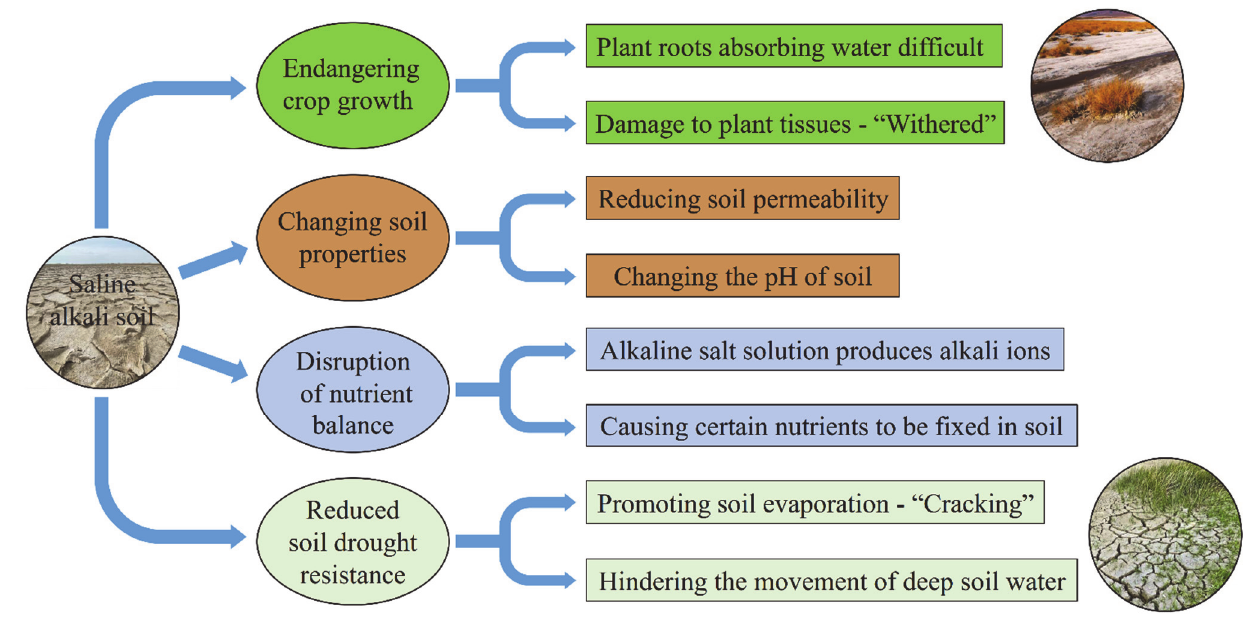
Figure 1. The hazards of saline − alkali